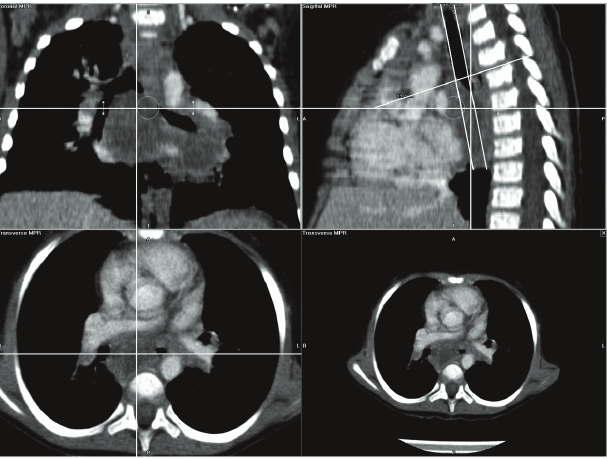
Fig. 2. The same three lines were digitally imposed on the sagittal MPR CT (top right image). The cross-hair in the coronal and axial planes indicates the subcarinal zone, and the soft-tissue density corresponds to a large subcarinal lymph node group.